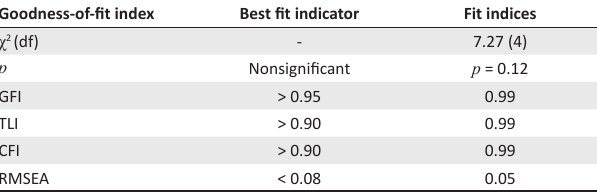
FIGURE 1: One-factor model of the Satisfaction with Life Scale with the indices of psychological well-being as outcome TABLE 3: Confirmatory factor analysis fit indices for the Satisfaction with Life Scale: one-factor model. Goodness-of-fit index